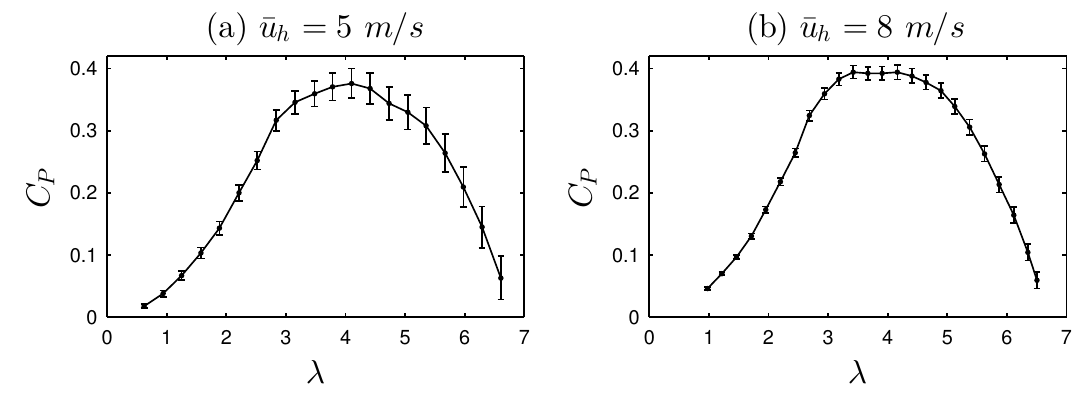
Figure A1. Variation of the power coefficient C P of the miniature turbine with the tip-speed ratio λ for two different incoming velocities: ( a ) ¯ u h = 5 m/s and ( b ) ¯ u h = 8 m/s. Error bars indicate values of the standard